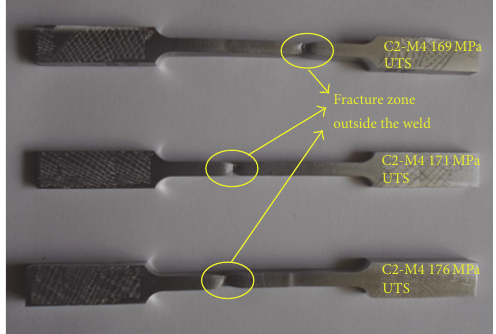
Figure 8: Localization of fracture under tensile tests for the SHBH welded specimens.